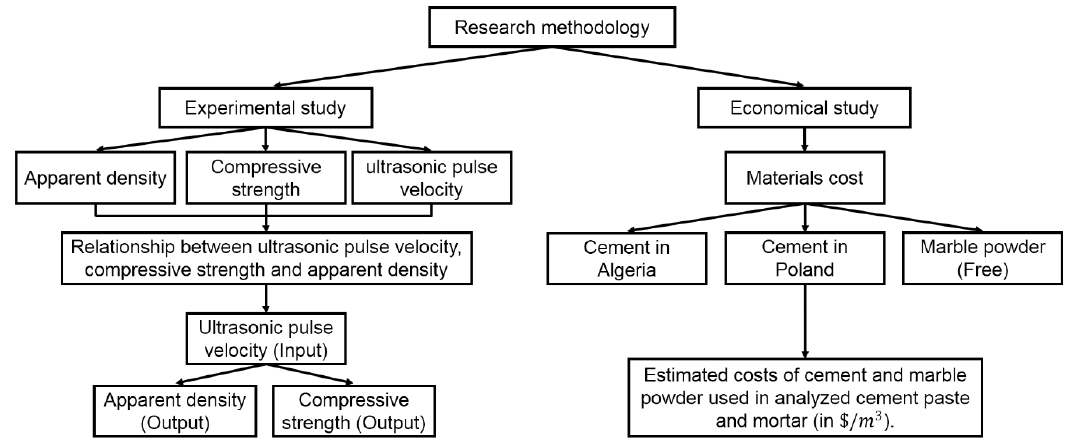
Figure 2. Flowchart of the research methodology.